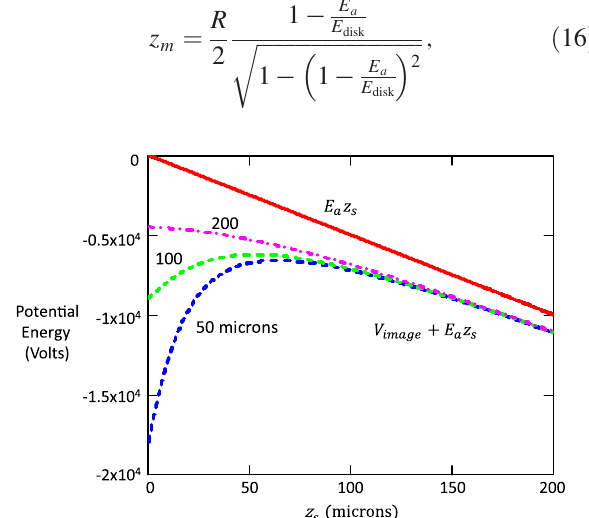
FIG. 5. The image-charge potential energy and the applied potential energy [as given by Eq. (14)] at the center of a 50-pC disk of charge as a function of its distance from a cathode with q 0 ¼ − q . The potential for an applied field of 50 MV = m is given by the solid red curve. The dashed curves are the potential energies for disks with 50-, 100-, and 200 - μ m radii. Note that the maximum of the potential barrier is approximately 50 μ m from the cathode surface and moves toward the cathode with an increasing disk